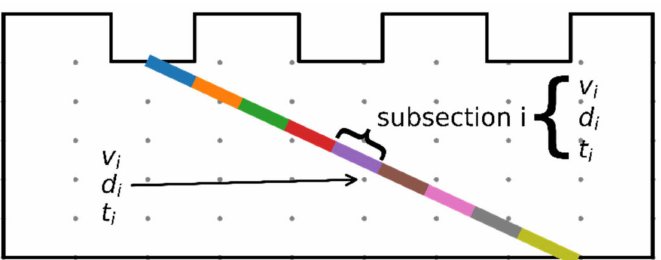
Figure 4. Simplified example showing a beam divided in subsections represented by different colors. How the properties are assigned to a specific subsection based on the closest point on the grid indicated by the